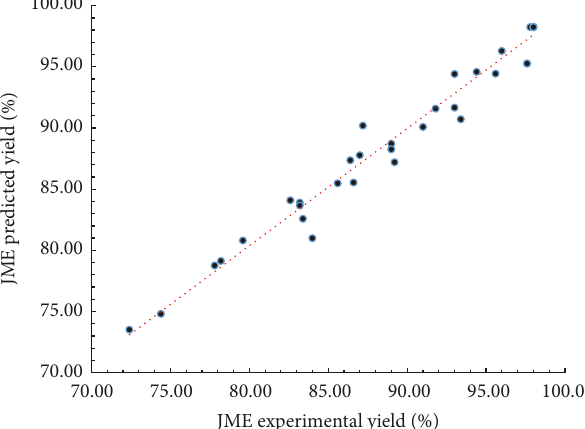
Figure 9: Comparative graph of JME predicted and experimental